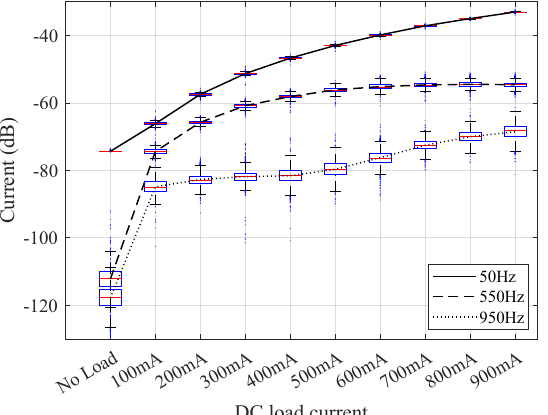
Figure 7. Box-plot of the levels of the different harmonics power as a function of DC load current.